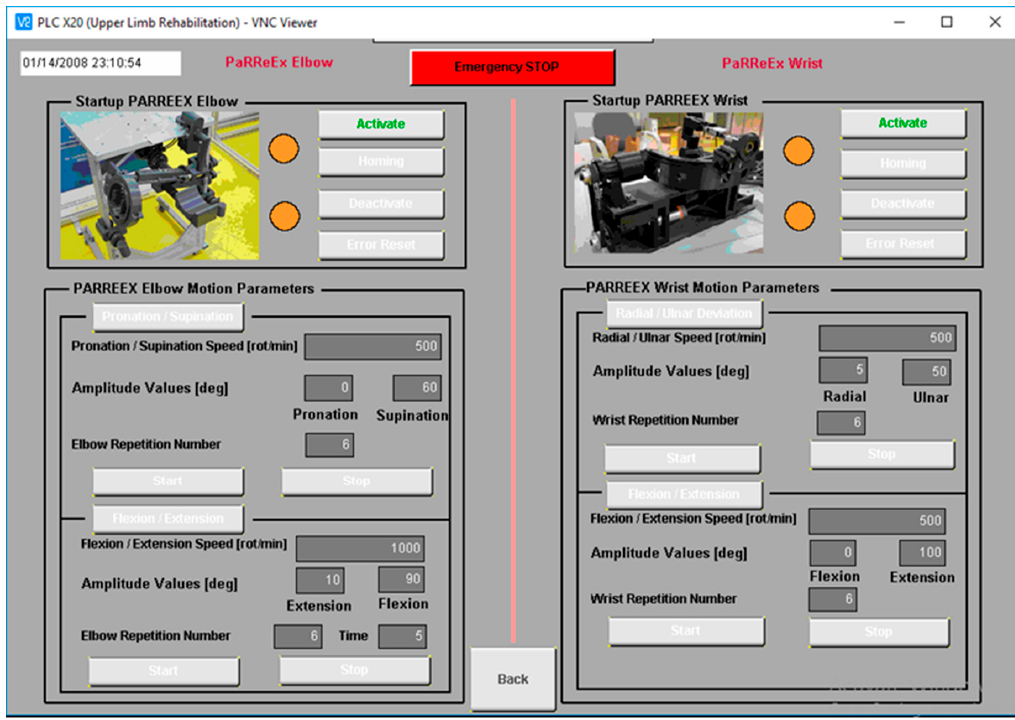
Figure 10. The Graphical User Interface (GUI) of ParReEx designed using Automation Studio [36].